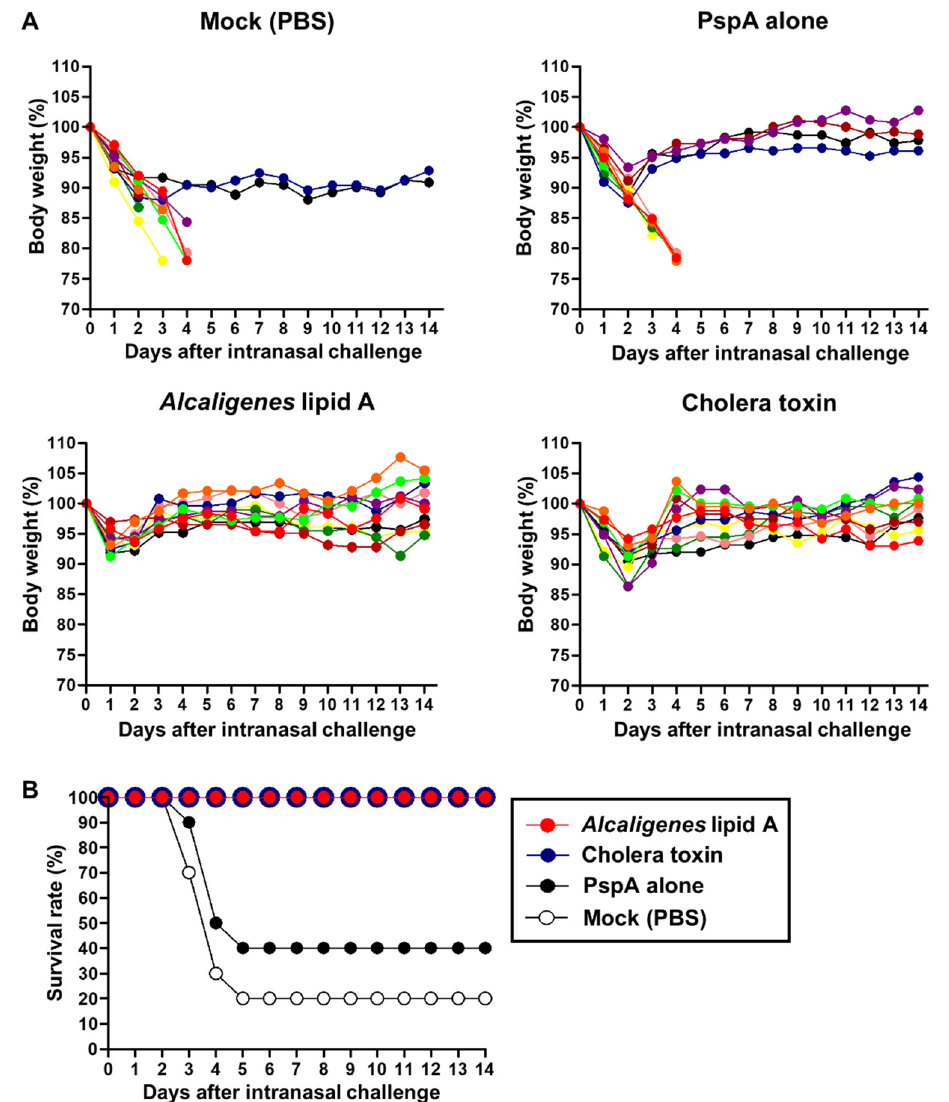
Figure 5. Nasal vaccination with PspA, together with Alcaligenes lipid A protects against Streptococcus pneumoniae infection. Nasal immunization with PspA with or without Alcaligenes lipid A or cholera toxin three times at one-week intervals. One week after the final vaccination, mice were nasally challenged with a lethal dose (5.0 × 10 6 CFU / mouse) of S. pneumoniae. Their body weights ( A ) and survival rates ( B ) were then monitored for 14 days. The data are combined from two independent experiments ( n = 10 per group).